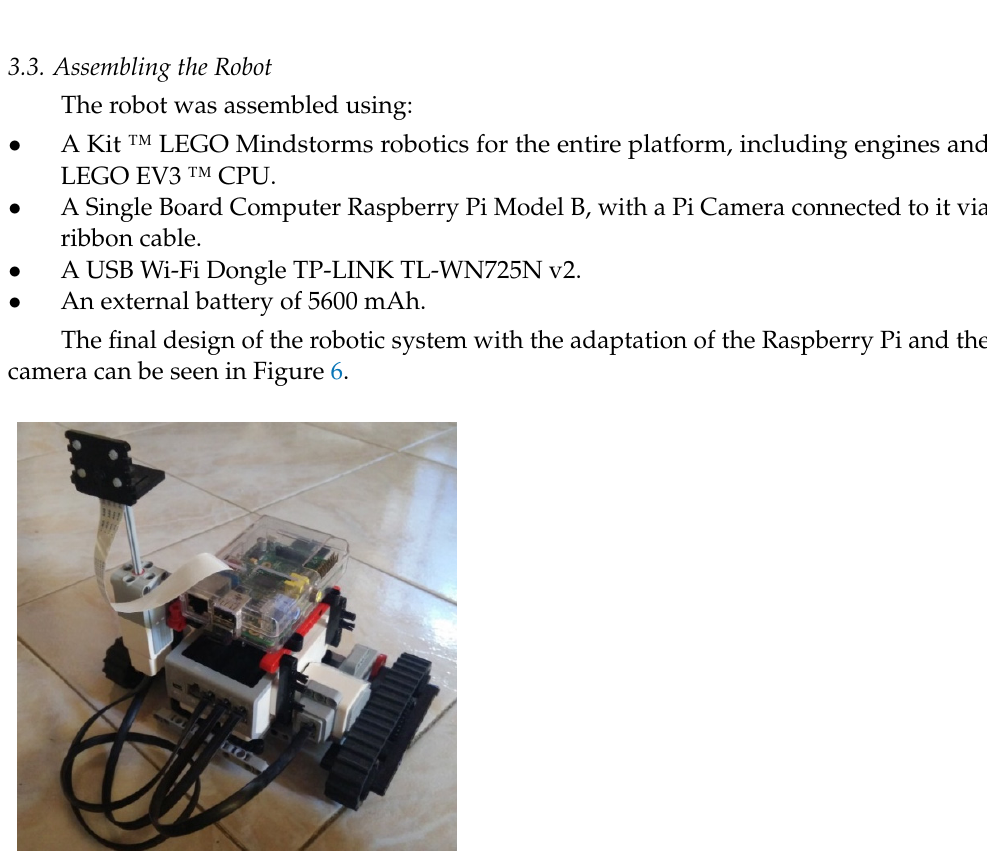
Figure 5. Smartphone app in ( a ) the automatic mode, and ( b ) manual mode.